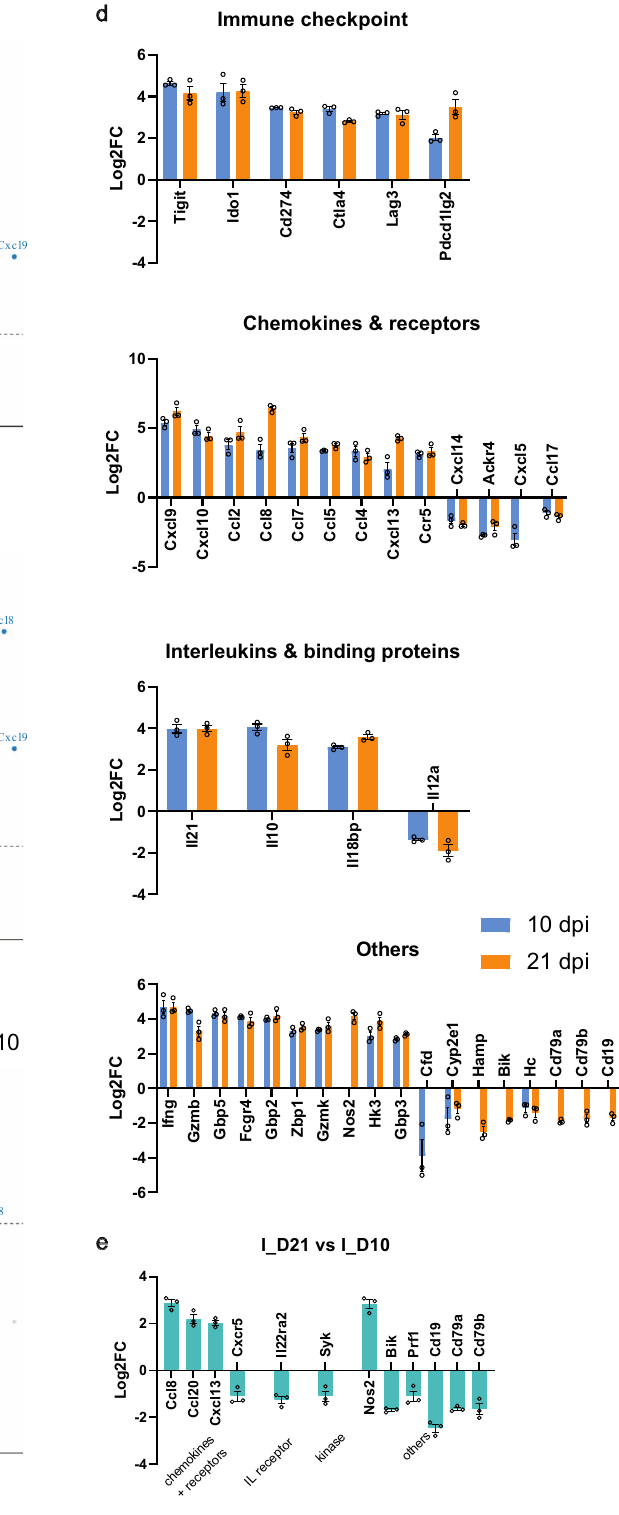
Fig.6|Detaileddifferentialgeneexpressionof T.b.brucei infectedlungtissue. a – c Volcano plots of differentially expressed (DE) genes plotting fold-change ( x - axis)versus signi fi cance( y -axis).Volcano plot of DEgenes of a 10 dpi( n =3)versus NI ( n =6) mice, b 21 dpi ( n =3) versus NI ( n =6) mice, c 21 dpi ( n =3) versus 10 dpi ( n =3) mice. d Overview of the DE genes with the largest fold change (Log2FC>3, Log2FC< − 1.5) in different biological categories. Graphs represent the Log2FC±